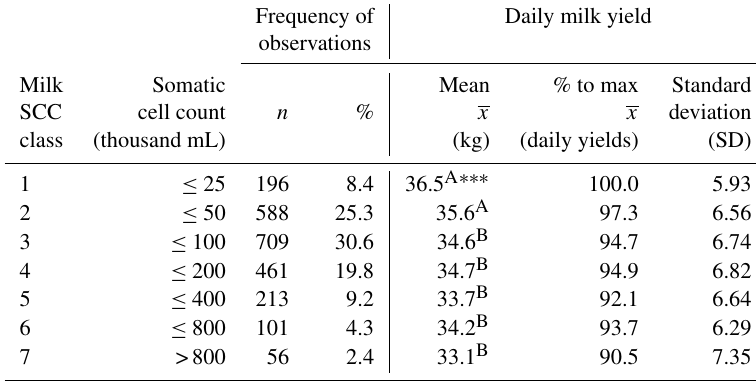
Table 4. Distribution of milk samples in SCC classes and daily milk yield. Frequency of Daily milk yield Milk